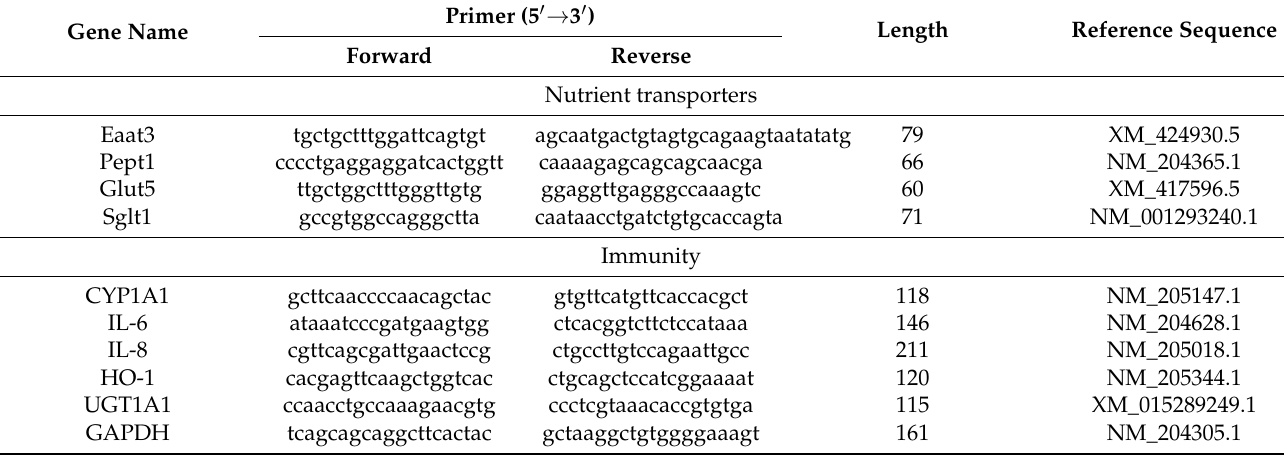
Table 2. Information of primers for quantitative real-time